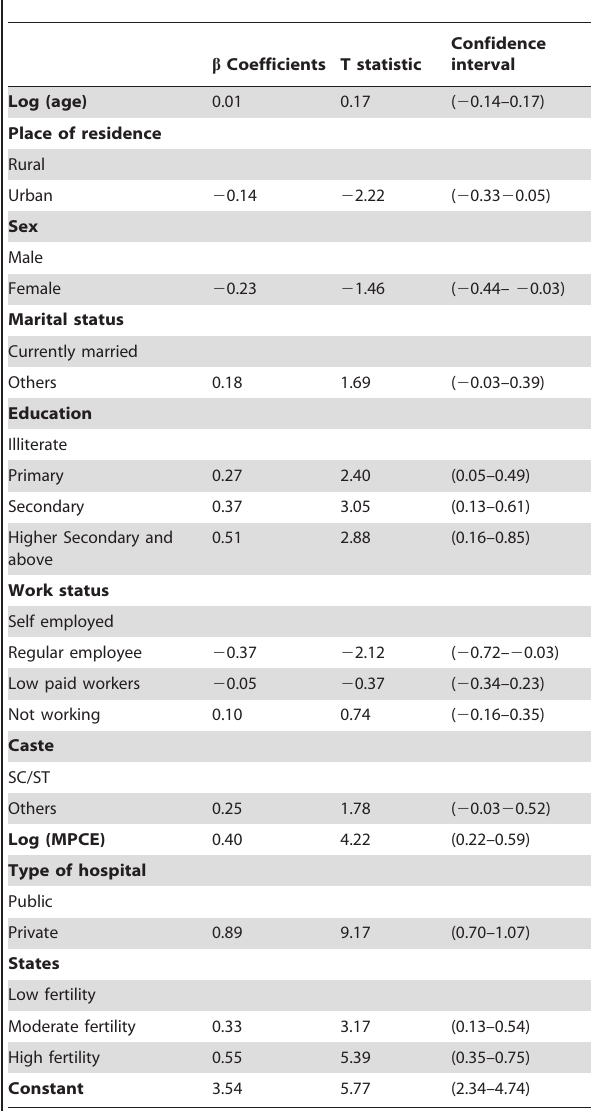
Table 4. Results from log transformed ordinary least square regression on cost of hospitalization in India.